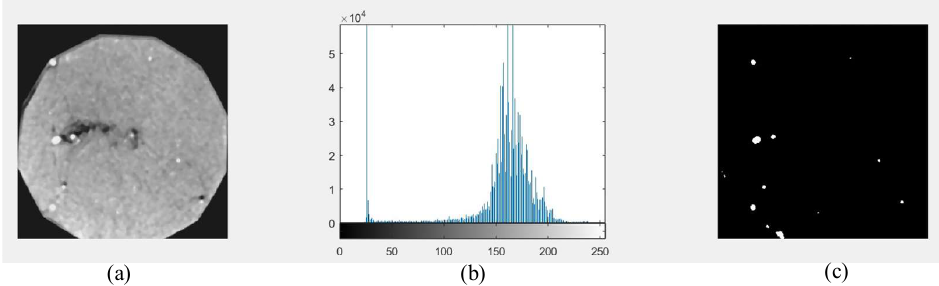
Figure 10. Threshold segmentation: ( a ) filtered image; ( b ) the histogram; ( c ) segmented image.